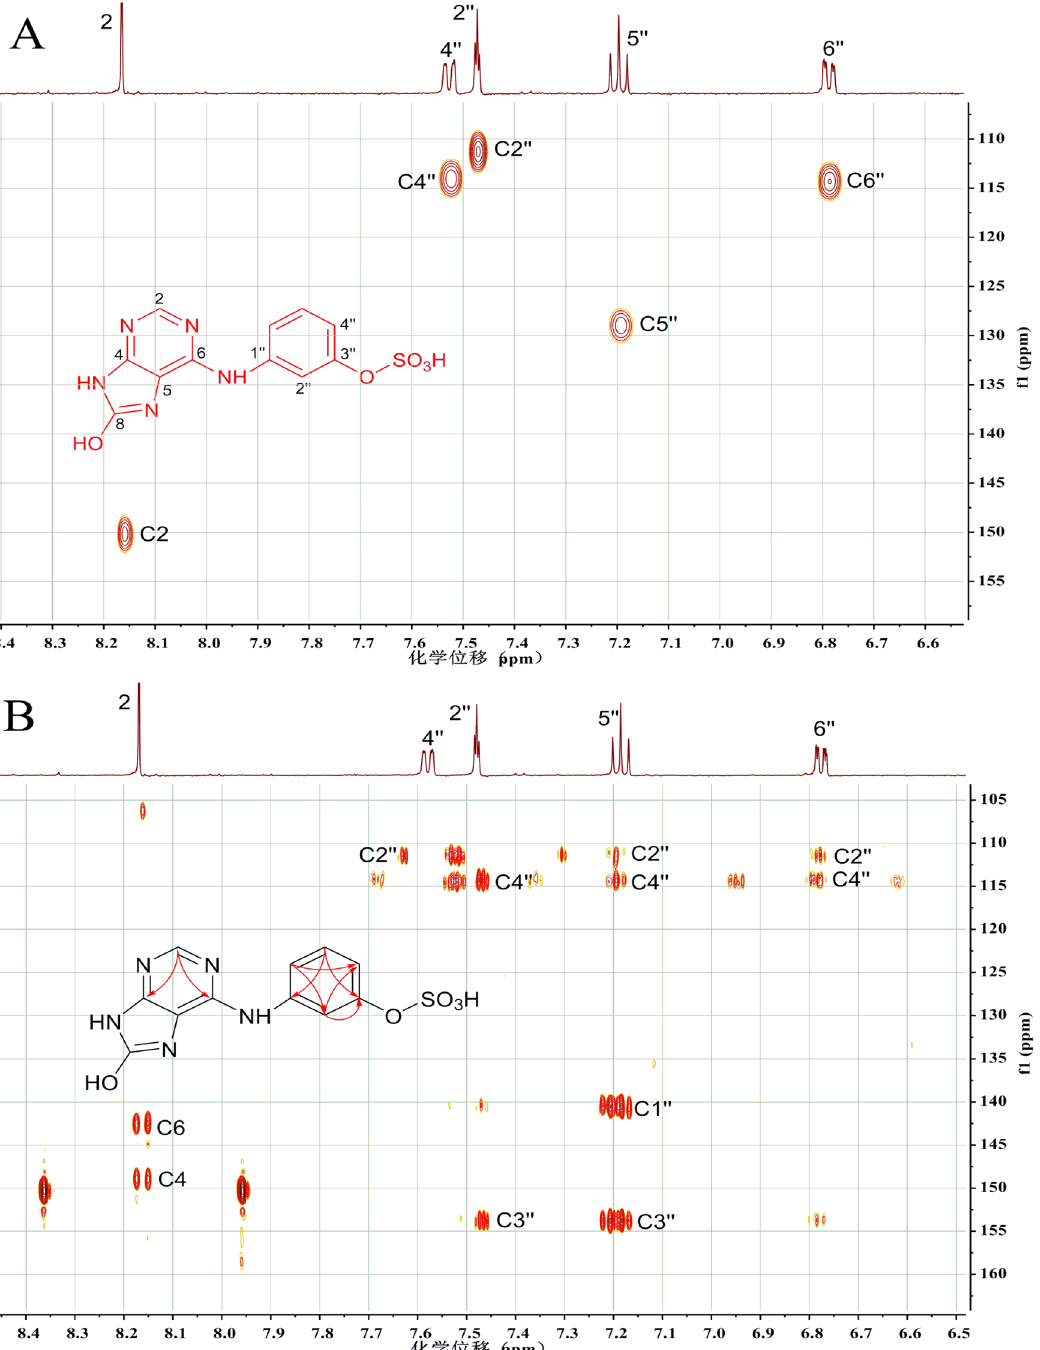
Fig 5. 1 H NMR derived HSQC (A) and HMBC (B) spectra of N 8 -hydroxy- N 6 -(3- O -sulfophenyl) adenine (structure see formula insert). A secondary metabolite in rat urine following WS070117 oral administration. The NMR spectra were obtained in deuterated DMSO on a 500 MHz NMR spectrometer, equipped with a 1.7 PA TXI microprobe. (A) HSQC (acquisition time: 2 h): red cross-peaks are stemming from CH, CH 2 and CH 3 protons. (B) HMBC (acquisition time: 6 h): the correlation information derived from the marked cross-peaks is summarized in the formula insert.